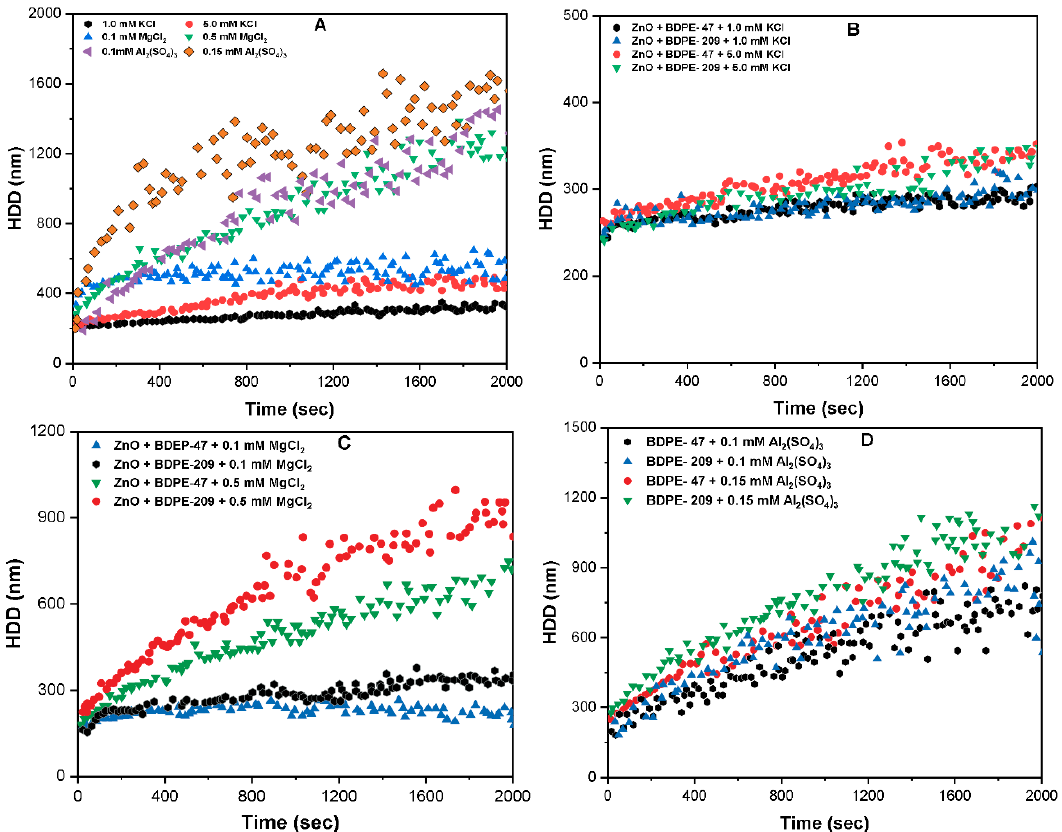
Figure 7. Influence of BDPE-47 and BDPE-209 on the aggregation kinetics of ZnO NPs (10 mg/L) in ( A ) KCl, MgCl 2 , and Al 2 (SO 4 ) 3 at different IS ((0–5) mM); ( B ) monovalent (0–5mM) KCl; ( C ) divalent ions ((0.1 and 0.5) mM of MgCl 2 ); and ( D ) trivalent ions ((0.1 and 0.15) mM Al 2 (SO 4 ) 3 ) at pH 7.